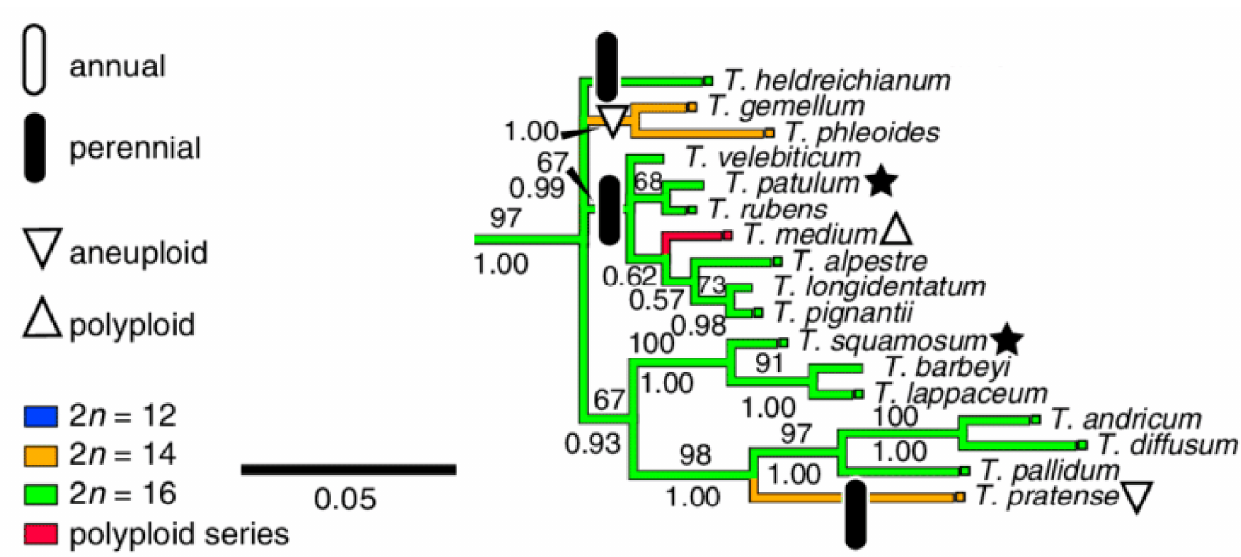
Figure 1. Branch of Trifolium section phylogenetic tree capturing T. medium and its closely related species (adapted from Ellison et al. [20]).